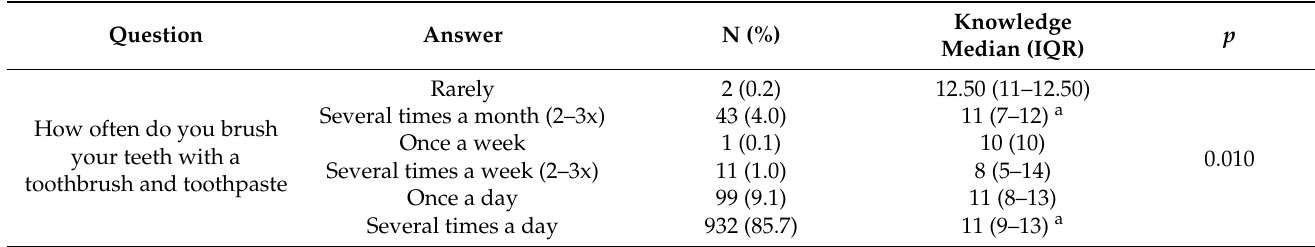
Table 3. Oral-hygienic habits—tooth brushing of students according to the average assessment of knowledge about oral